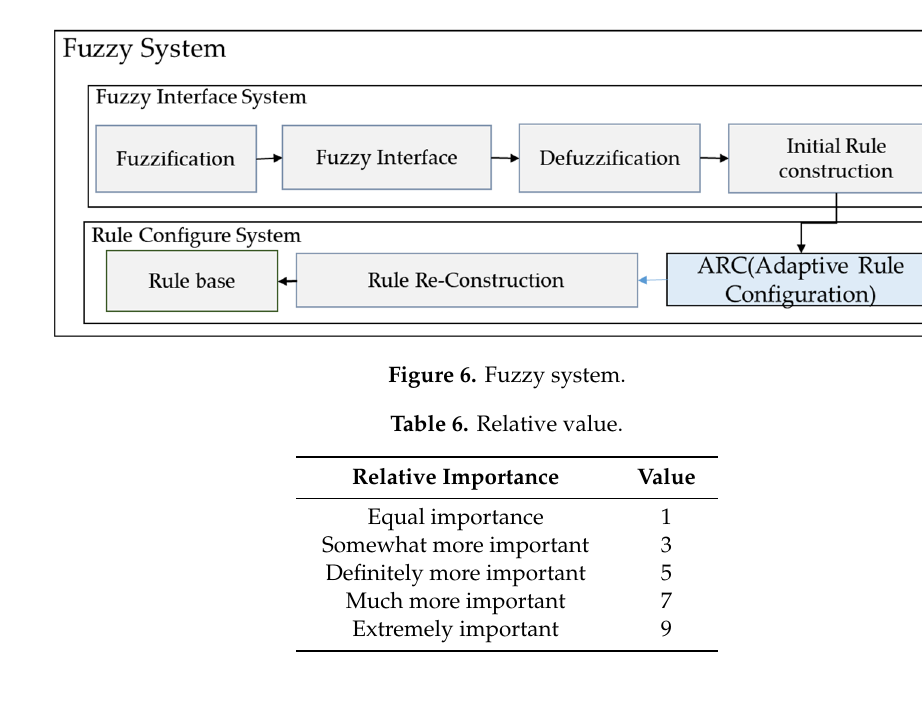
Figure 5. Hierarchical structure.